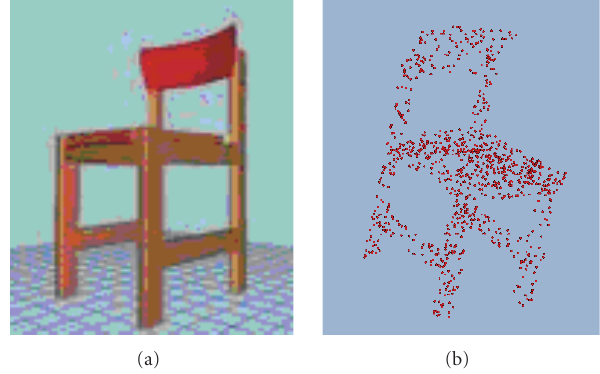
Figure 4: Model chair and its voxel model.